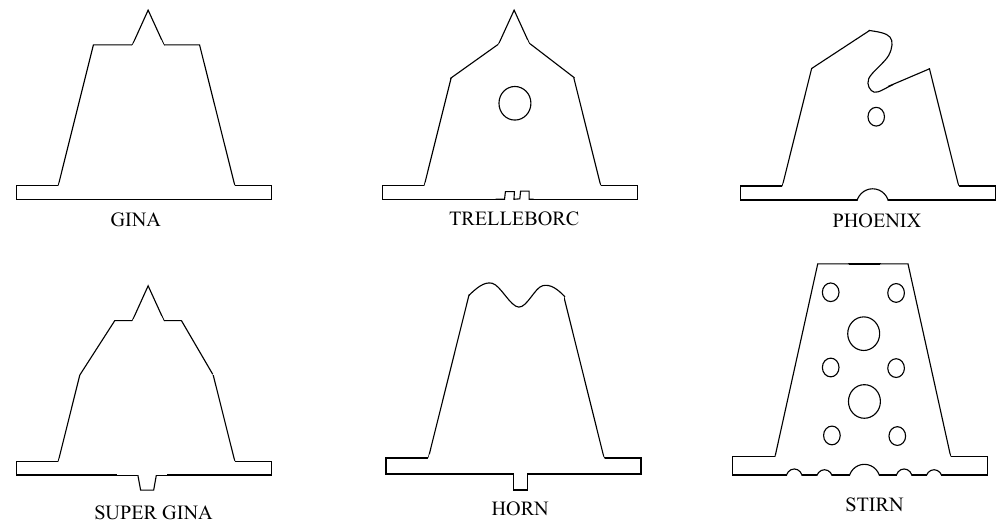
Figure 4. The different cross-sectional shapes of GINA gaskets (redrawn according to Hu et al. [23]). The abovementioned different cross-sectional shapes of GINA gaskets are divided into four typical types [23], and the four typical types are shown in Figure 5.